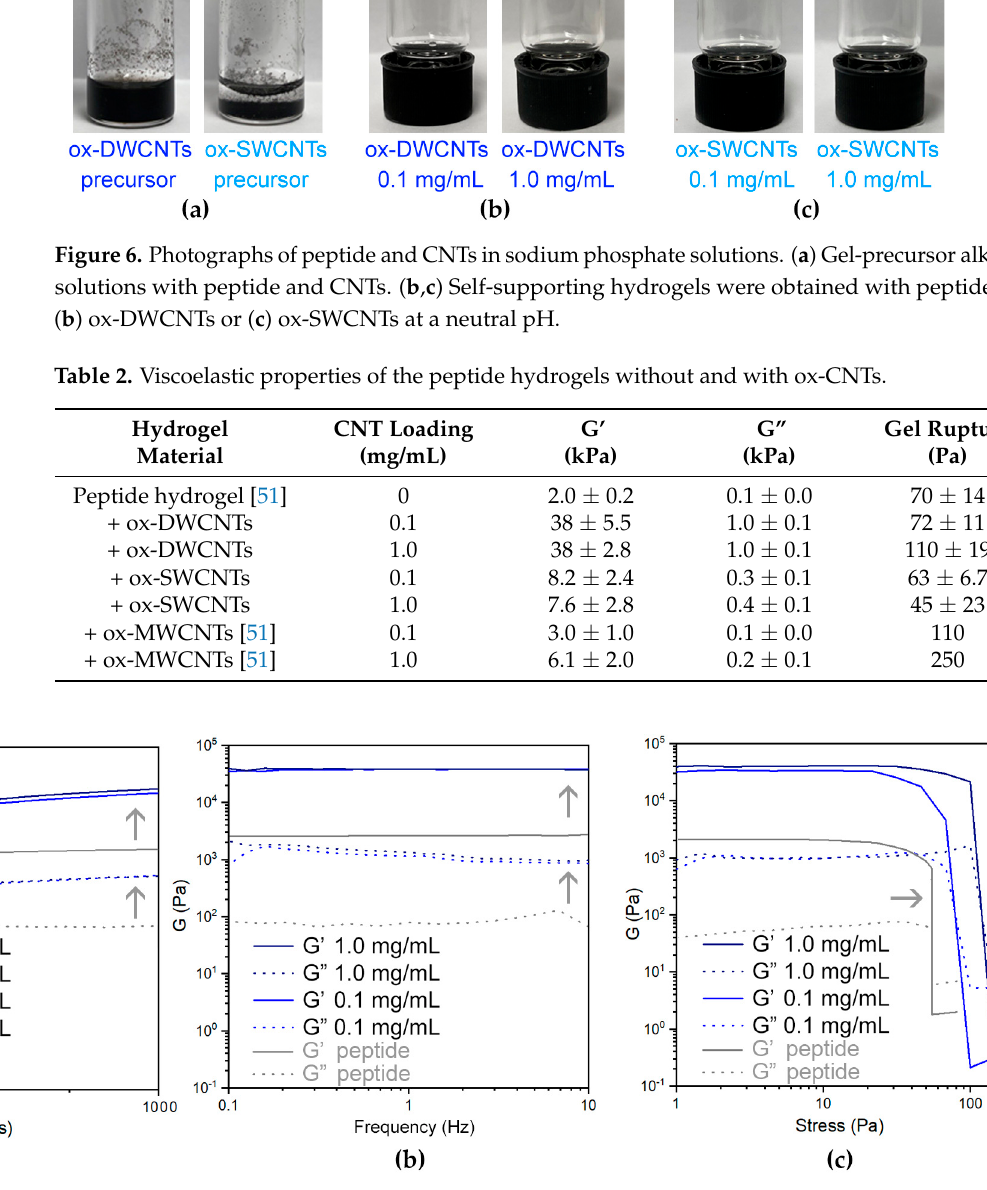
Figure 6. Photographs of peptide and CNTs in sodium phosphate solutions. ( a ) Gel-precursor alkaline solutions with peptide and CNTs. ( b , c ) Self-supporting hydrogels were obtained with peptide and ( b ) ox-DWCNTs or ( c ) ox-SWCNTs at a neutral pH.